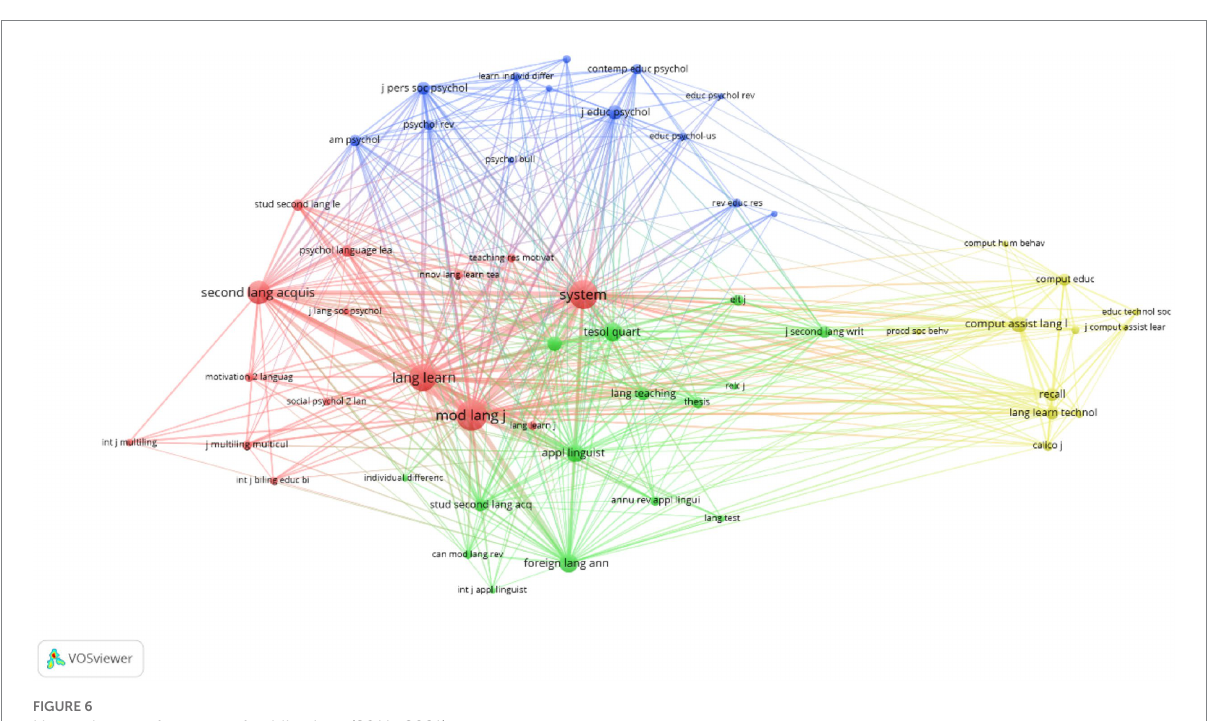
FIGURE 6 Network map of sources of publications